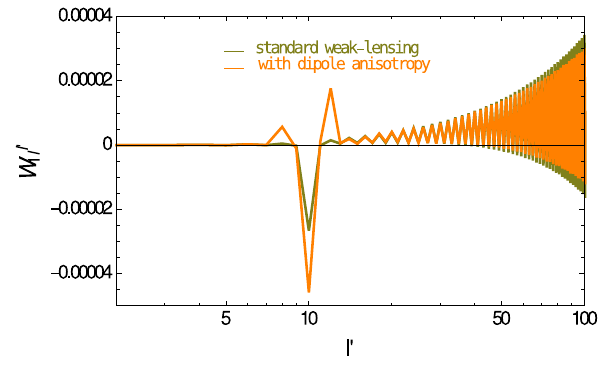
Fig. 5 The plot of W l (cid:3)